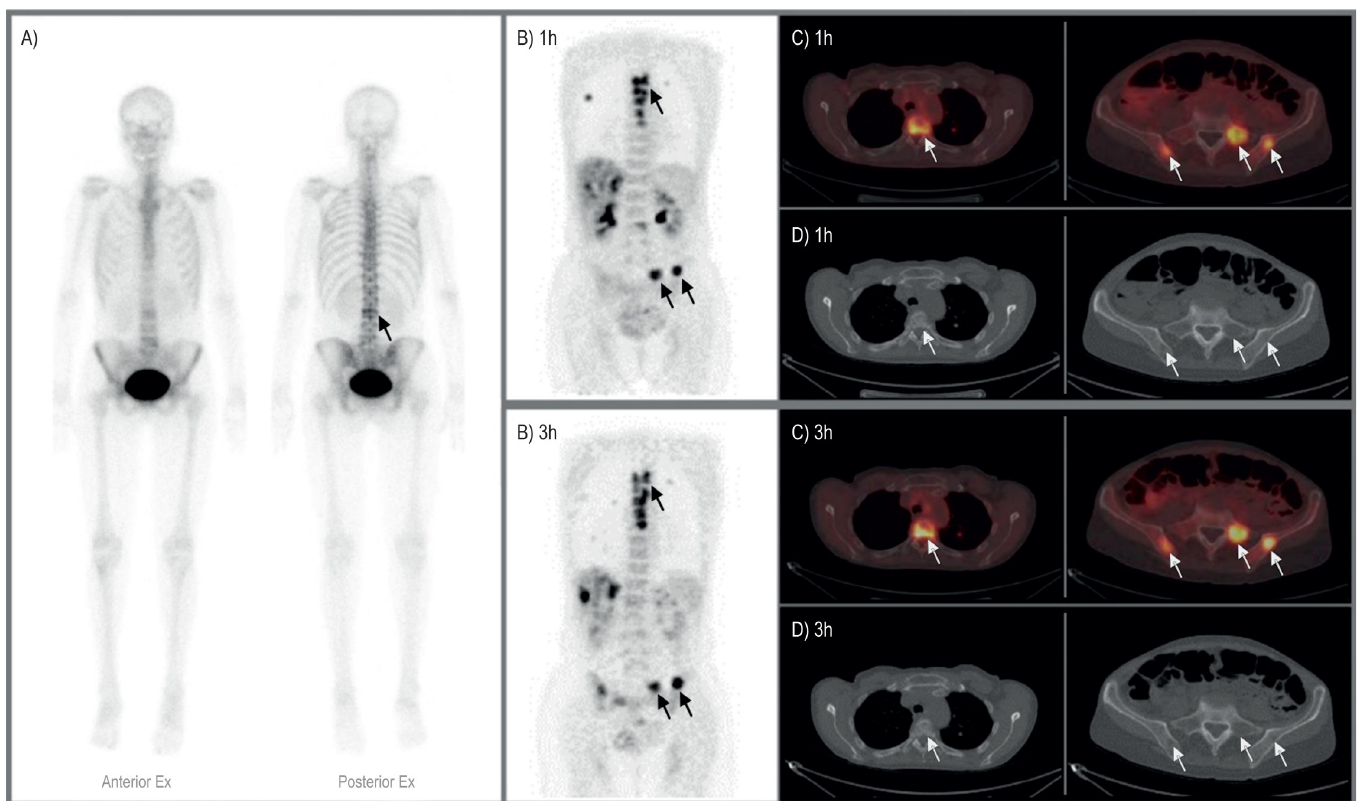
Fig 1. A 54-year-old woman with true-positive bone metastases. A) Whole-body bone scintigraphy shows only one area with increased uptake of 99mTc-DPD (arrow). B) FDG-PET 1h and 3h images show multiple osseous metastases in the spine and the pelvis. C) Axial FDG-PET/CT images demonstrating FDG-avid lesions in the spine, sacrum, and iliac bones. D) Axial CT images at the same level as C show osteolytic